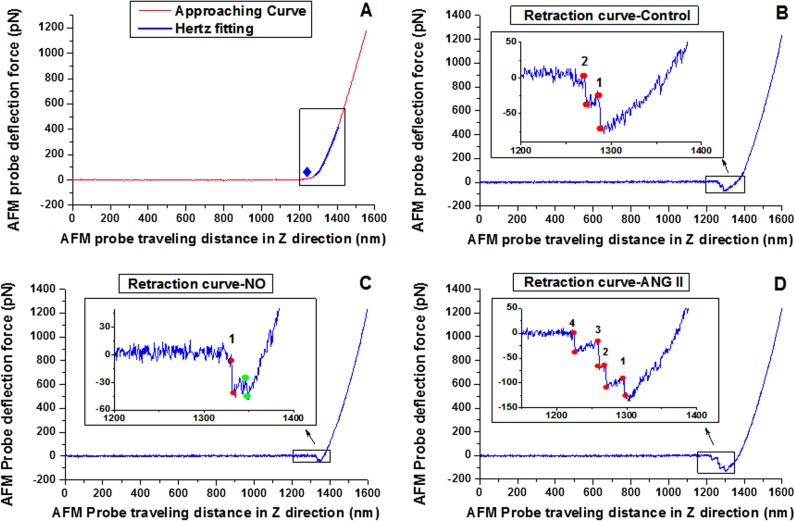
Representative force curve recorded by AFM.
(A) An example of an approach curve recorded by AFM (red). The blue diamond in the black square is the estimated contact point with the VSMC where the AFM cantilever is in contact with the cell plasma membrane and begins to bend. The blue line is the Hertz fitting to the approach curve. (B) Representative retraction force curve recorded by AFM for pre-drug period (control). (C) Representative retraction force curves after treatment with NO. (D) Representative retraction force curve after treatment with ANG II. The height between the paired red spots was used to compute the adhesion force and the rupture number was used to evaluate the adhesion probability. The 1.5 fold of the average noise (signal fluctuation) was set as the threshold of adhesion force and only the rupture force higher than threshold was considered as the real unbinding force between cell membrane and AFM cantilever. The rupture indicated by two green spots was considered as noise and omitted in adhesion probability computation (C). The snaps with low gap height were not the particular characteristics of the NO or ADO treated force curve, they also appeared in control and ANG II treated force curve and were omitted as well.